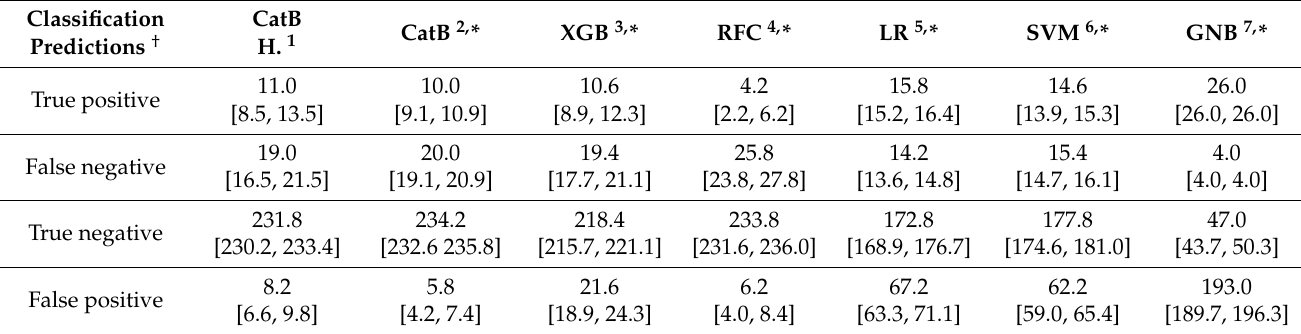
Table 5. Classification predictions of the TAVI mortality prediction model and comparison with other classifiers.